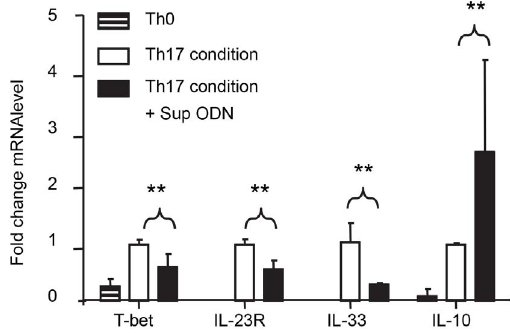
Figure 4. Gene expression by Th17 cells. Naive T cells from C57BL/ 6 mice were cultured under Th17 polarizing conditions as described in Fig 1. mRNA was isolated on day 3 and the expression of genes encoding T-bet, IL-23R, IL-33 and IL-10 determined by RT-PCR. Relative mRNA levels were calculated by comparison to Th17 cells generated in the absence of ODN after normalization to GAPDH mRNA levels. Each bar represents the mean + SD of 3 independent experiments. **, p , 0.01.